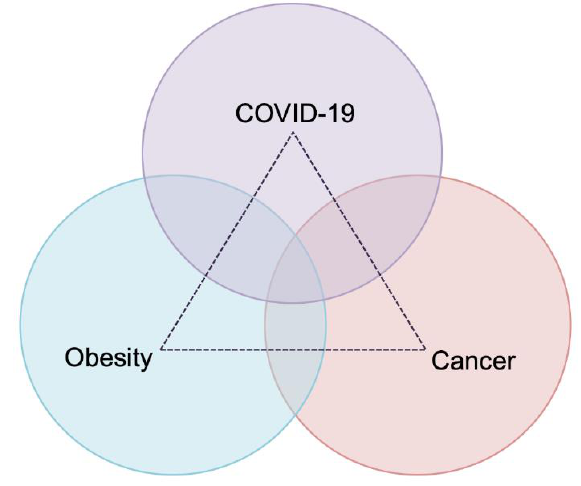
Figure 1. The triangle of pandemic doom.